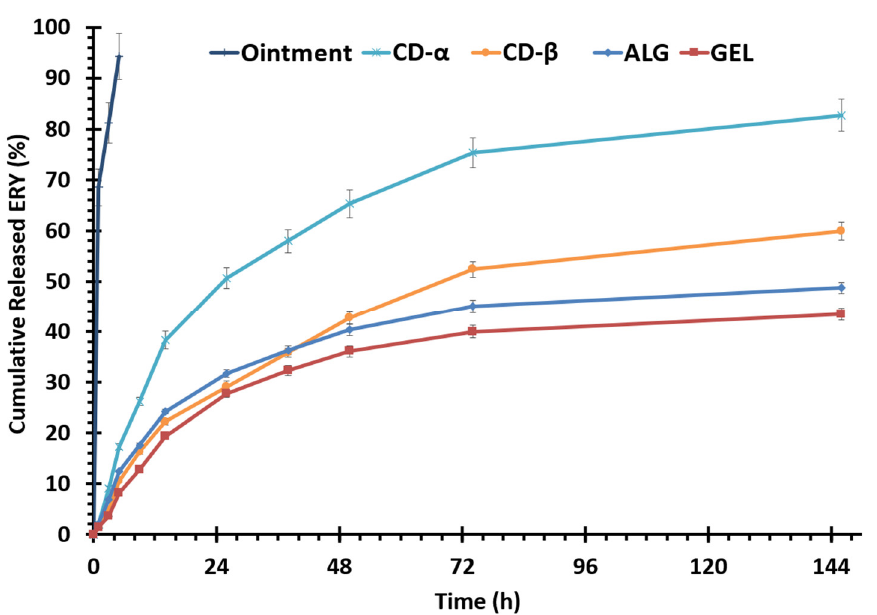
Figure 5. Cumulative release of erythromycin (expressed as a percentage) vs time profiles for the marketed ophthalmic ointment of erythromycin, GEL, ALG, CD-α, and CD-β ocular inserts in PBS (pH = 7.4) at 37 °C.